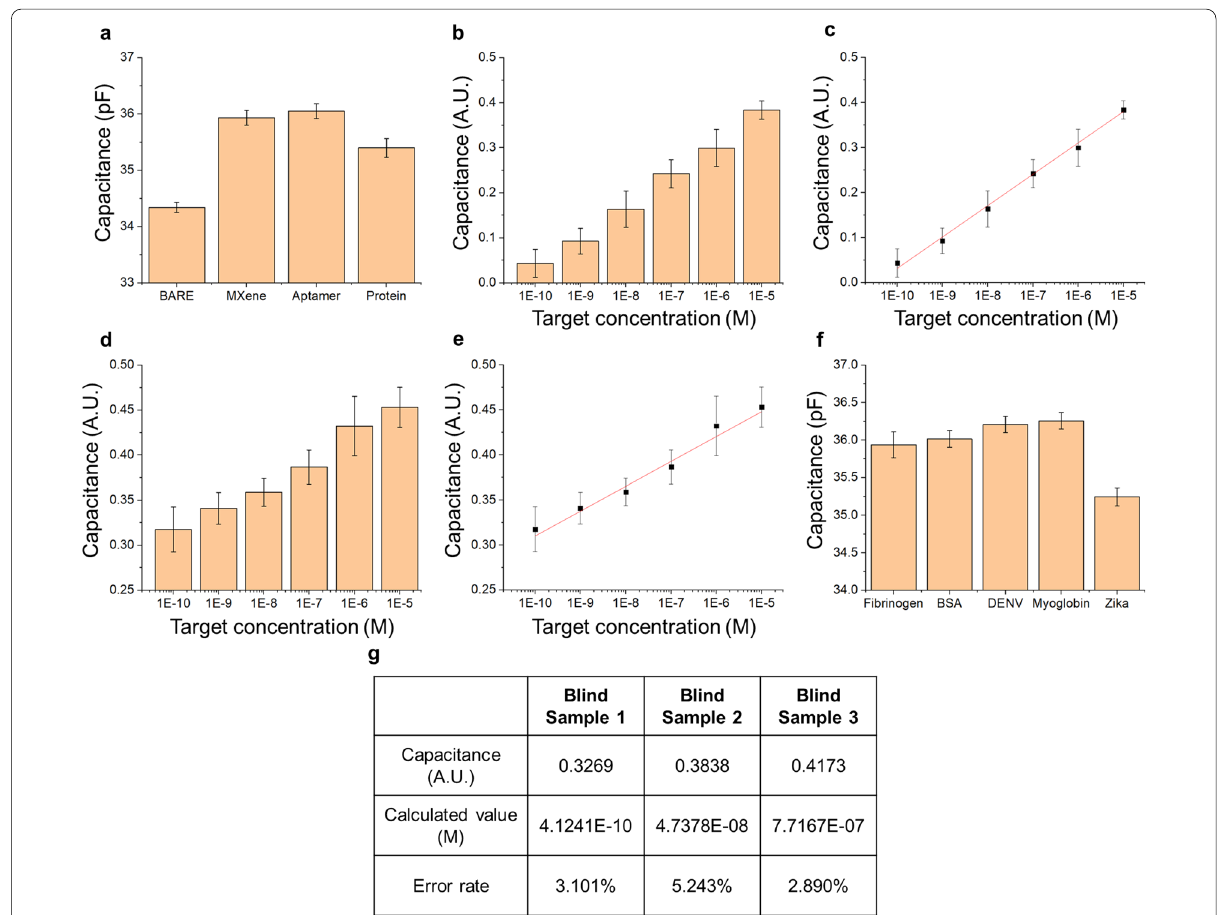
Fig. 4 a Capacitance trend according to the binding step; b Capacitance trend by zika virus envelope protein concentration in DIW; c Calibration curve according to zika virus envelope protein concentration in DIW; d Capacitance trend by zika virus envelope protein concentration in 10% human serum; e Calibration curve according to zika virus envelope protein concentration in 10% human serum; f Selectivity of the